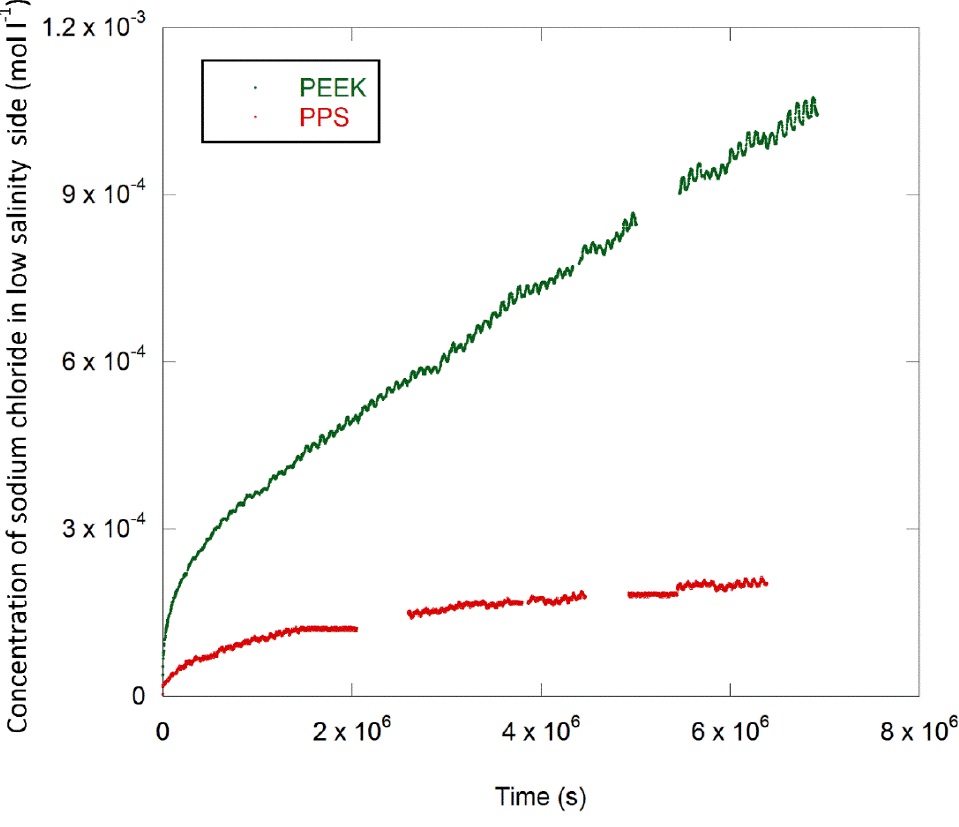
Figure 9. The transport of sodium chloride through PPS and polyether ether ketone (PEEK) films. Table 3. Diffusion coefficients for sodium chloride and potassium chloride in PEEK and PPS under ambient conditions.